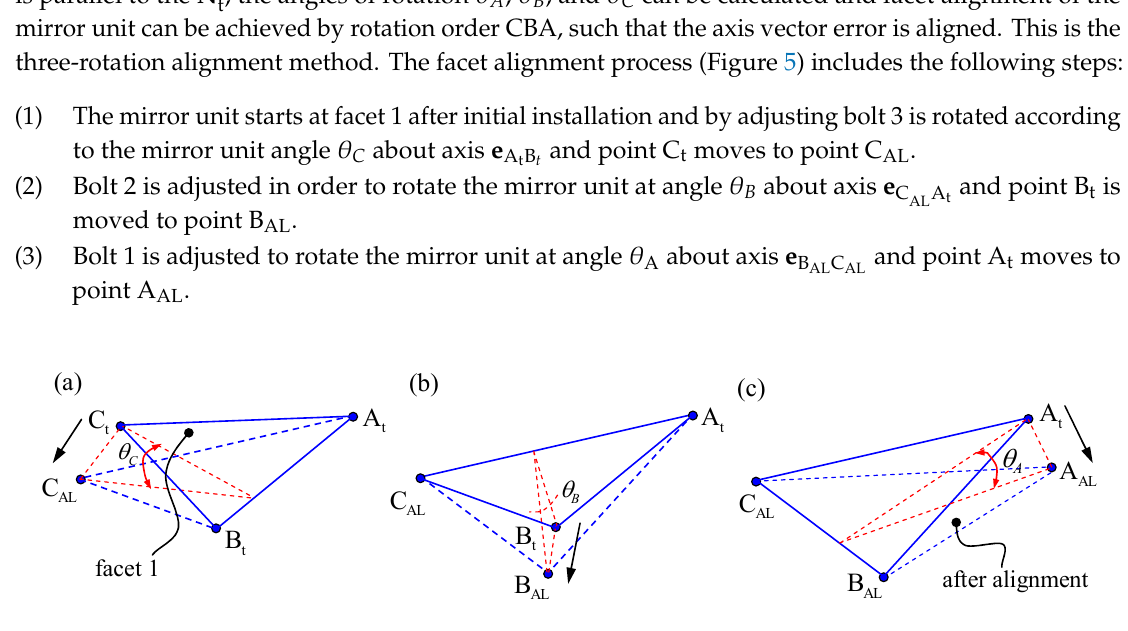
Figure 5. The three-rotation alignment process of the mirror unit consists of: ( a ) rotation about axis A t B t , ( b ) rotation about axis C AL A t , and ( c ) rotation about axis B AL C AL .